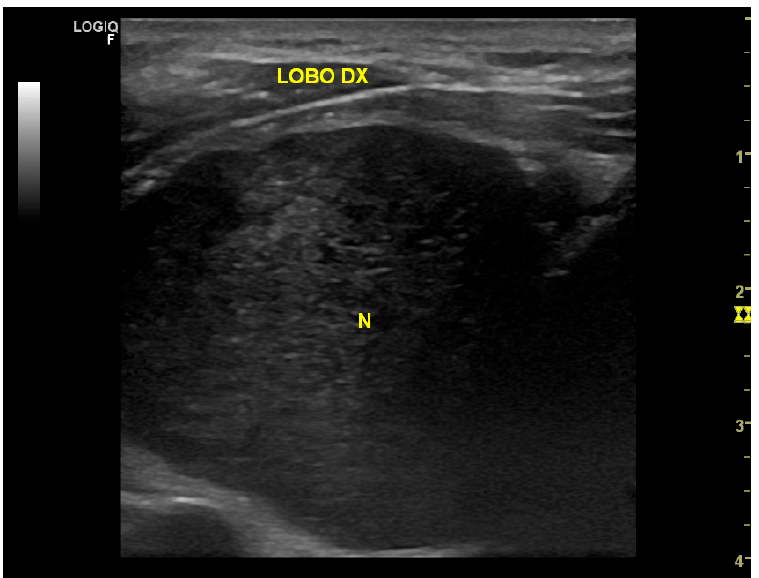
Figure 1. US image showing a hypoechoic nodule of a maximum diameter of 47.5 mm with regular margins and with some contextual anechoic areola.